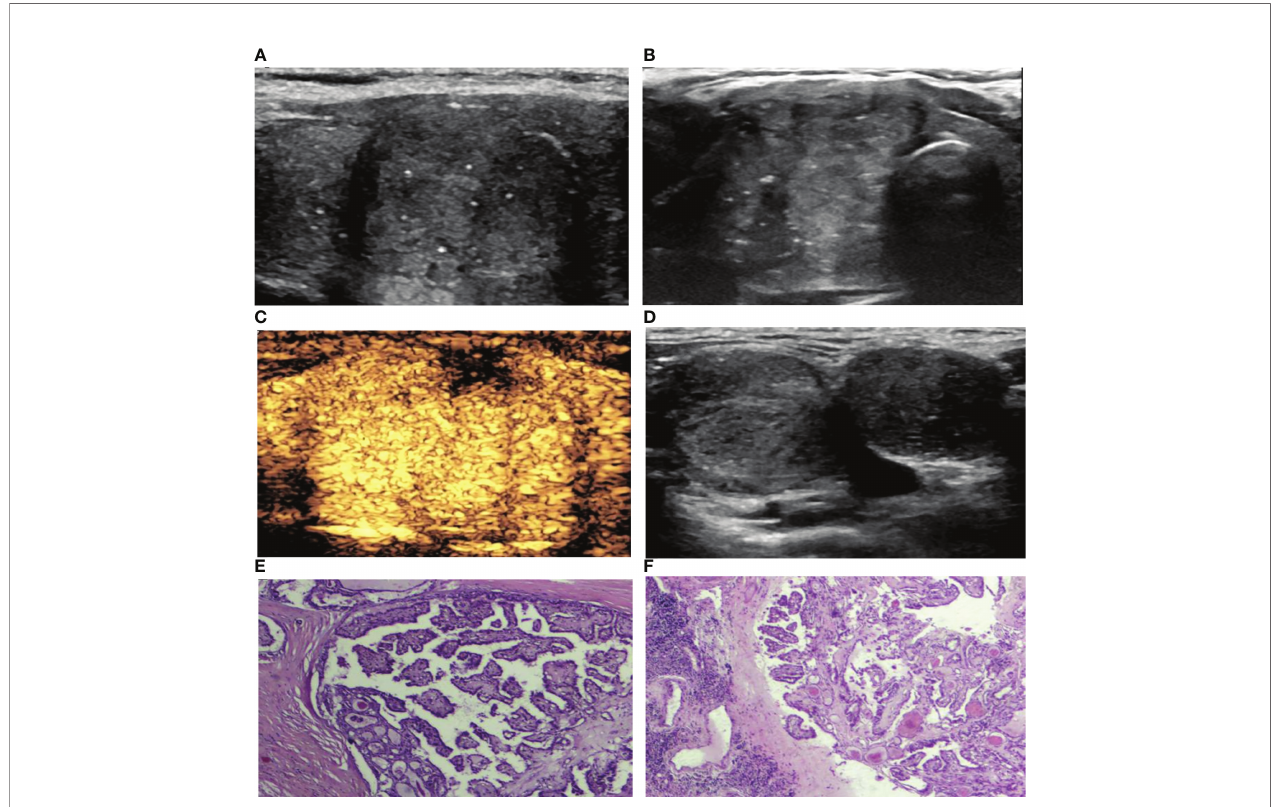
FIGURE 1 | A 39-year-old woman with PTC. (A) Preoperative ultrasound images showing that the size of the tumor was approximately 3.85*3.27*2.01 cm in the right lobe, and the boundary was ill-de fi ned, with microcalci fi cations. (B) Transverse sonogram showing that the contact range with the capsule was approximately >50%. (C) CEUS showing heterogeneous hyperenhancement in the nodule with interrupted thyroid capsule integrity (no enhancement area). (D) Lymph nodes were metastatic in levels III-IV of the right neck with the normal structures disappearing. (E) Surgical pathology con fi rming PTC (HE, hematoxylin-eosin, original magni fi cation, ×40). (F) Surgical pathology con fi rming cervical lymph node metastasis from PTC (hematoxylin-eosin, original magni fi cation,